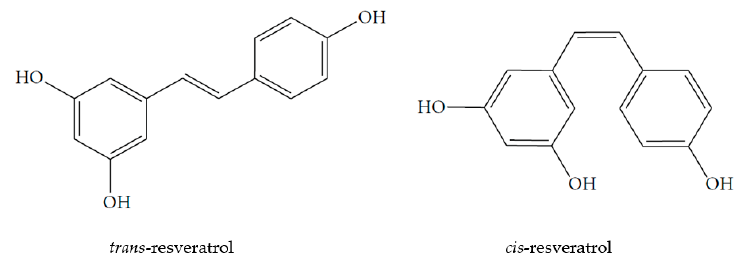
Figure 3. Structure of trans - and cis -resveratrol [135].